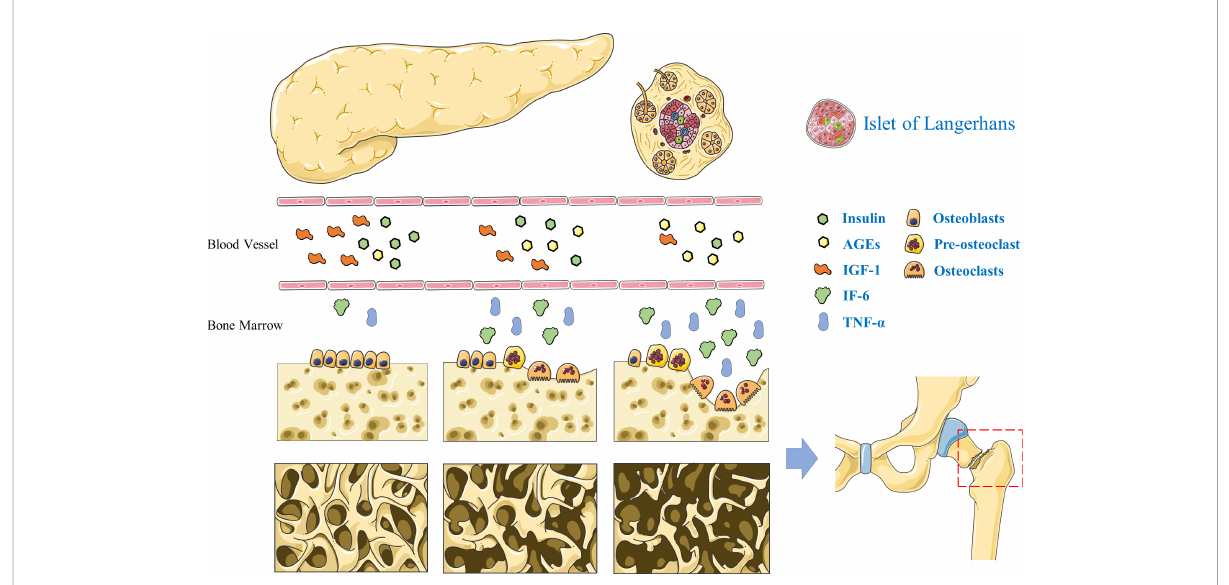
FIGURE 1 Pathogenesis of diabetic bone disease. The de fi ciency of insulin and insulin-like growth factor-1 leads to decreased bone formation in T2DM. Advanced glycation end products inhibited osteoblasts differentiation. Interleukin-6 and tumor necrosis factor a can promote the proliferation and differentiation of osteoclast precursor cells into mature osteoclasts and accelerate the process of bone